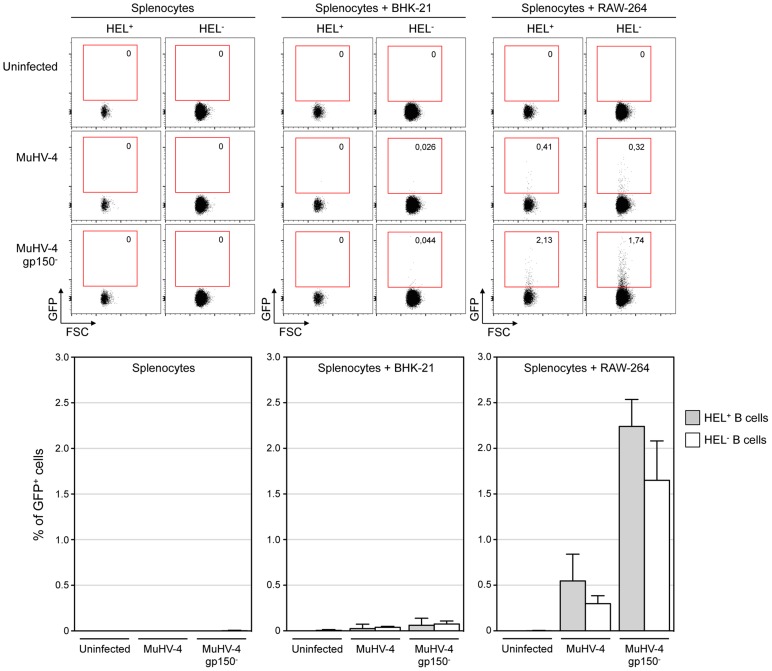
HEL+ and HEL− B cells are both infected by MuHV-4 in vitro.In vitro infection by co-culture assay was performed as described in the material and methods. Briefly, freshly isolated SWHEL splenocytes were exposed to free viruses or co-culture with BHK-21 or RAW-264 cells previously infected with EF1α-eGFP+ or EF1α-eGFP+-gp150− MuHV-4. GFP expression in HEL+ and HEL− B cells was monitored by FACS after 48 h of co-culture. Representative FACS plots are shown on top, compiled data representing average percentage and standard deviation are shown below. Splenocytes were identified based on FSC SSC parameters, excluding BHK-21 and RAW-264. Cells were then gated on CD19+ CD11b− and GFP expression was monitored in HEL+ and HEL− B cell. Data were obtained from two independent experiments with two splenocytes suspensions in each.